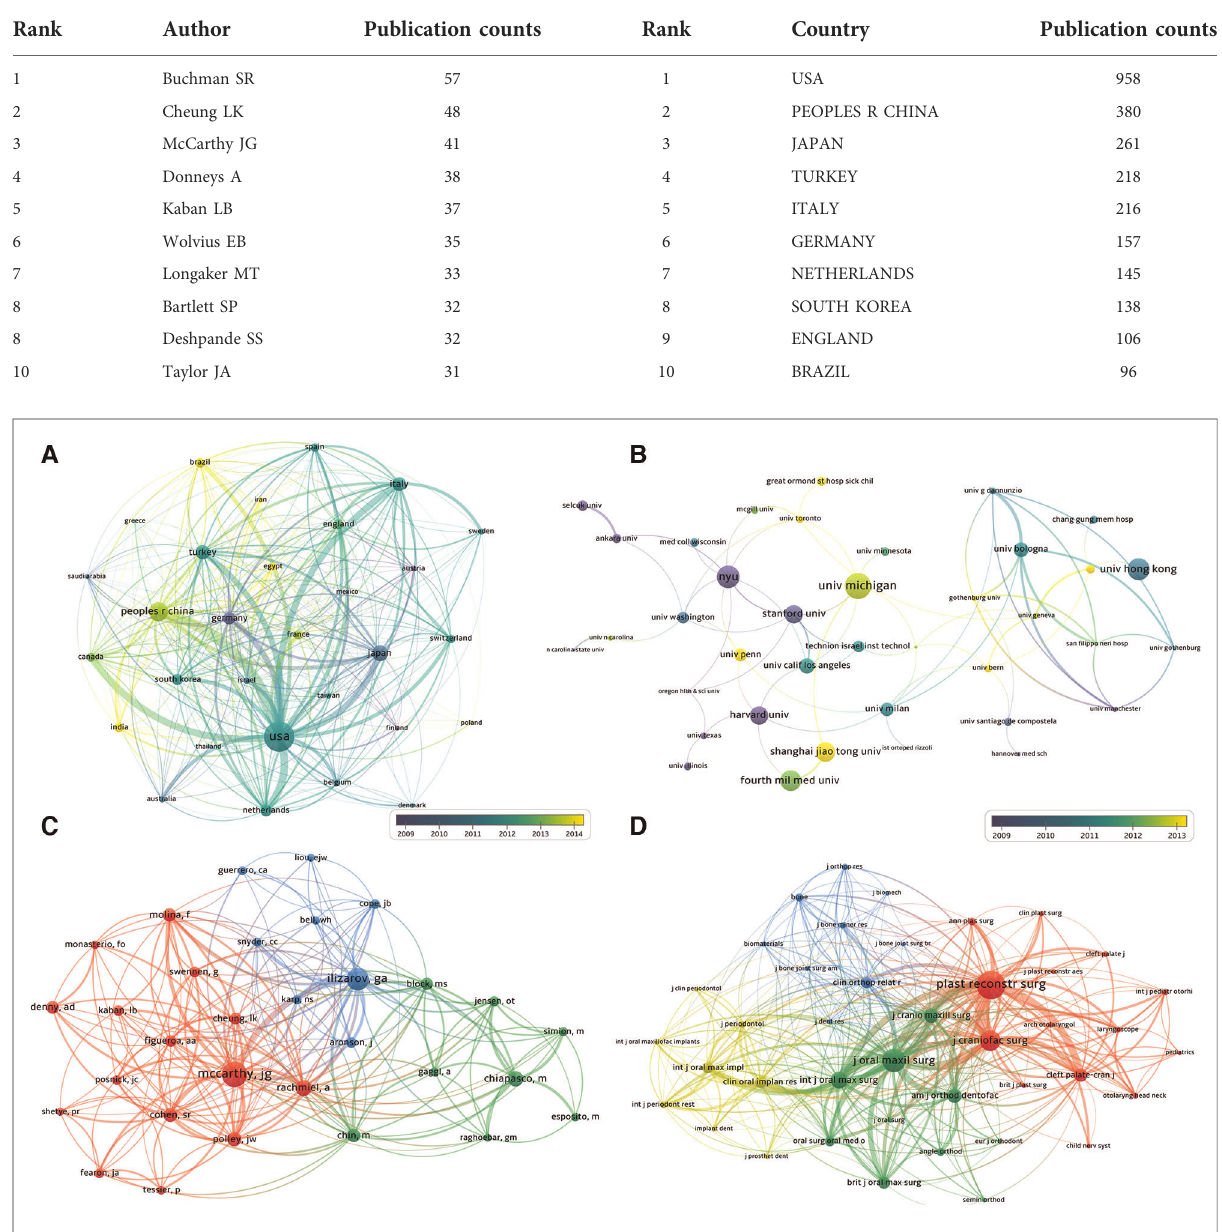
FIGURE 3 ( A ) Co-occurrence analysis of countries; ( B ) Co-occurrence analysis of institution; ( C ) clustering analysis of cited authors; ( D ) clustering analysis of cited